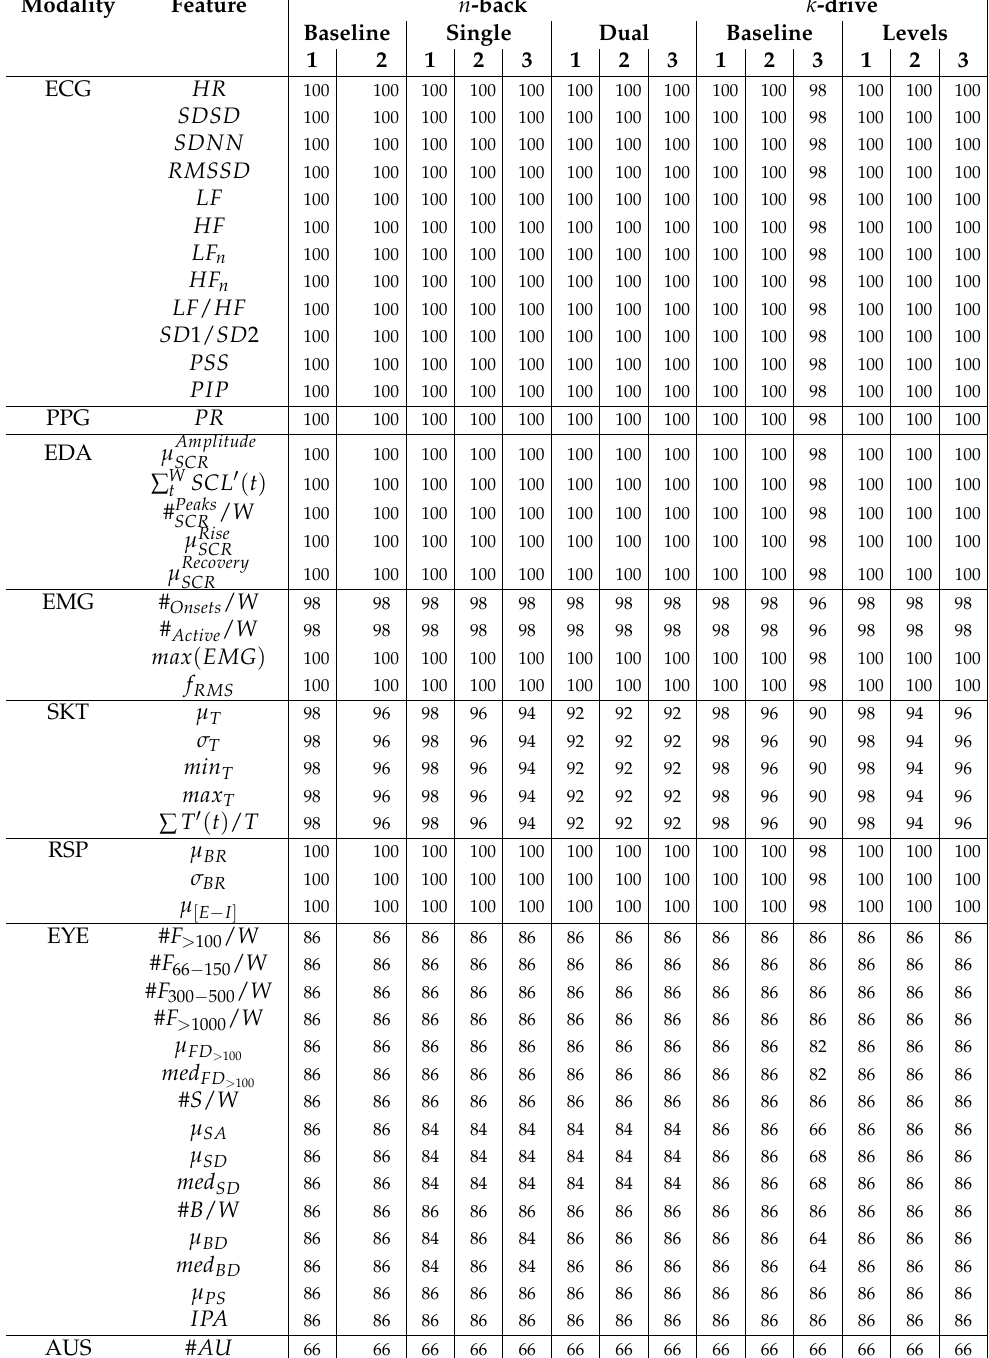
Table A3. Number of records used for statistical evaluation, after removing corrupted records (see Section 2.11) and outliers in integer percent. The total number of subjects in this study was 51. Methodological details are presented in Section 2.11. The extracted features are described in Sections